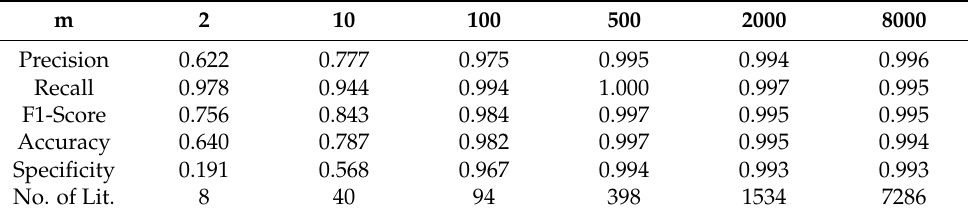
Table 9. Performance of TM with SSL continuous feature scheme on Bankruptcy dataset.